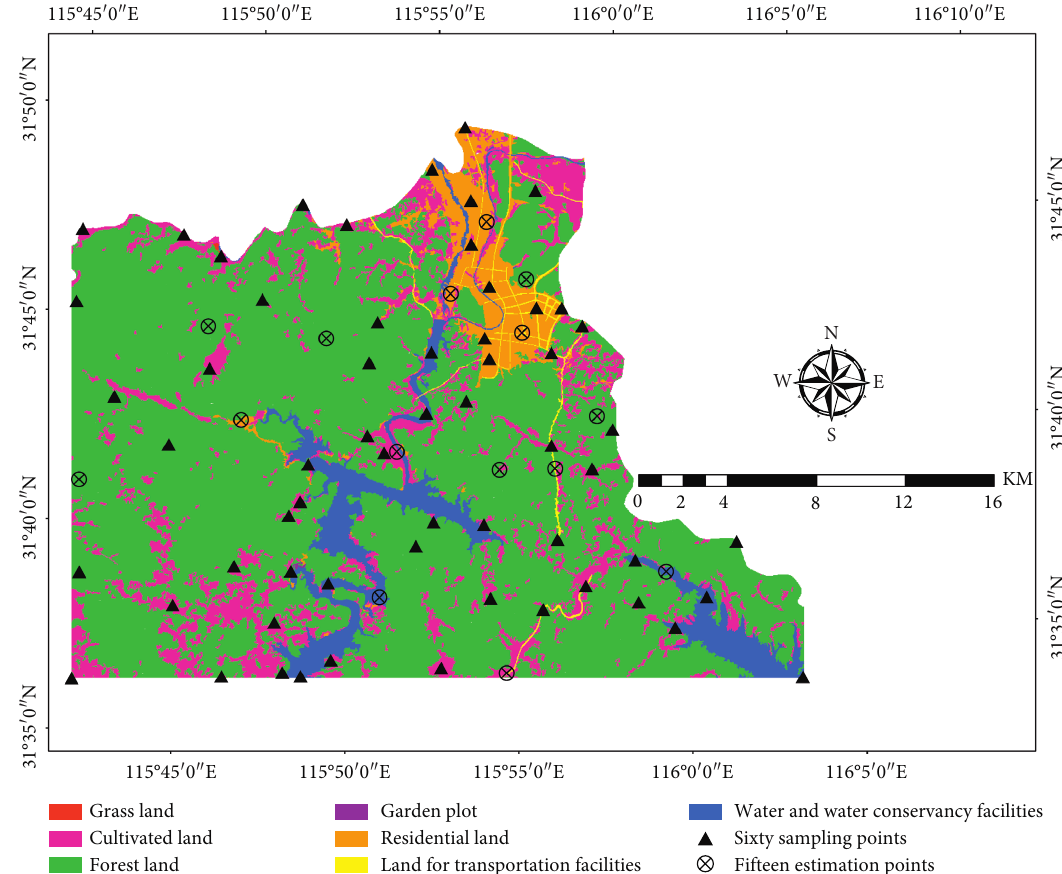
Figure 3: Distribution map of discrete points and pending valuation points in study area-1.